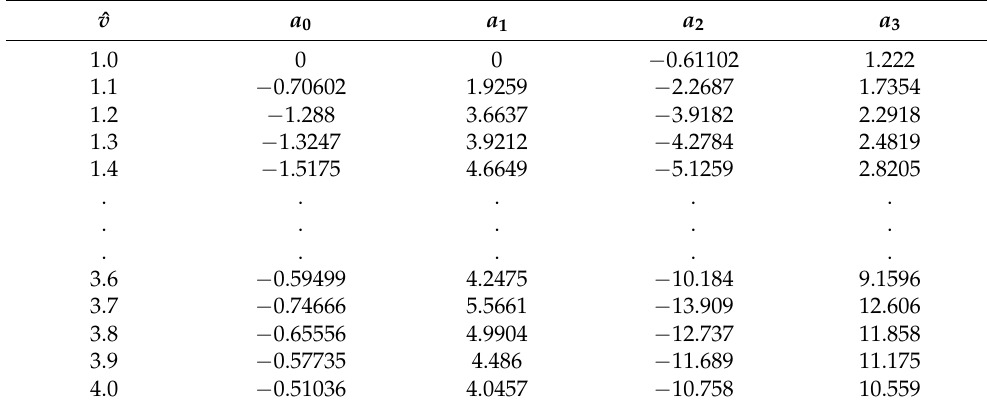
Table 1. The table illustrates various coefficients of different fittings on frequency plots, at specific levels of voltage. a i : coefficients for frequency fitting.